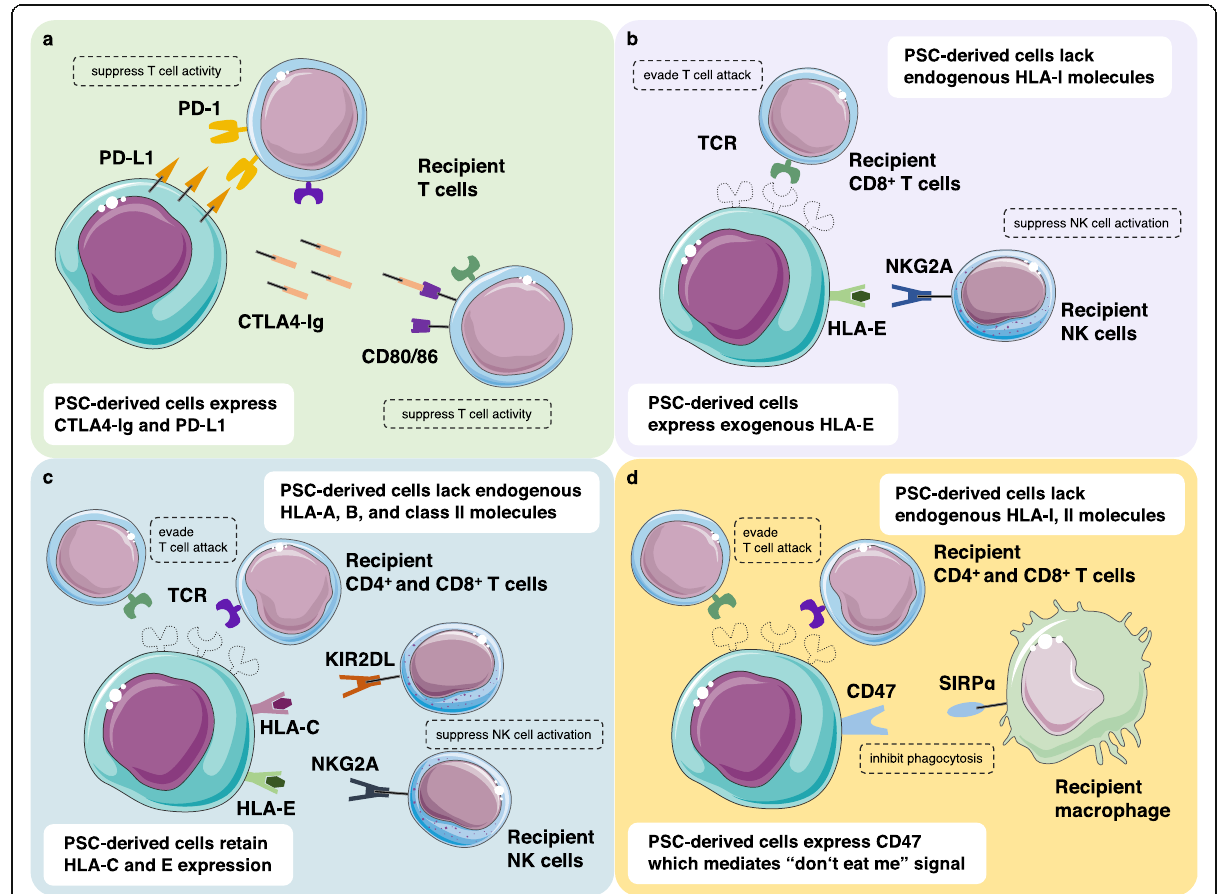
Fig. 1 Genetic modification of pluripotent stem cells to suppress or evade recipient immune cell attack. a Gene transduction of CTLA4-Ig and PD-L1 to PSCs. b HLA-I gene knockout in combination with HLA-E gene transduction. c HLA-A, B, and class II gene knockout in combination with retained expression of endogenous HLA-C and E. d HLA-I and II gene knockout in combination with CD47 gene